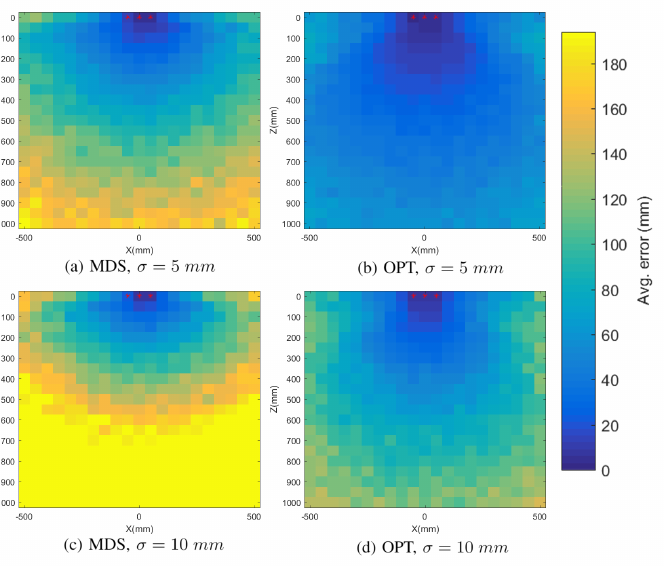
Figure 6. Average object-positioning error (Euclidean distance between the real and the computed point) in different regions and for different noise levels, with SMACOF MDS (MDS) and LM-BFGS optimization (OPT). Table 2. Per-axis object-positioning error and Euclidean distance between the real and the computed point for different noise levels, with SMACOF MDS and LM-BFGS optimization, averaged for the 0 < z < 1000 mm; − 500 mm < x < 500 mm and y = 0